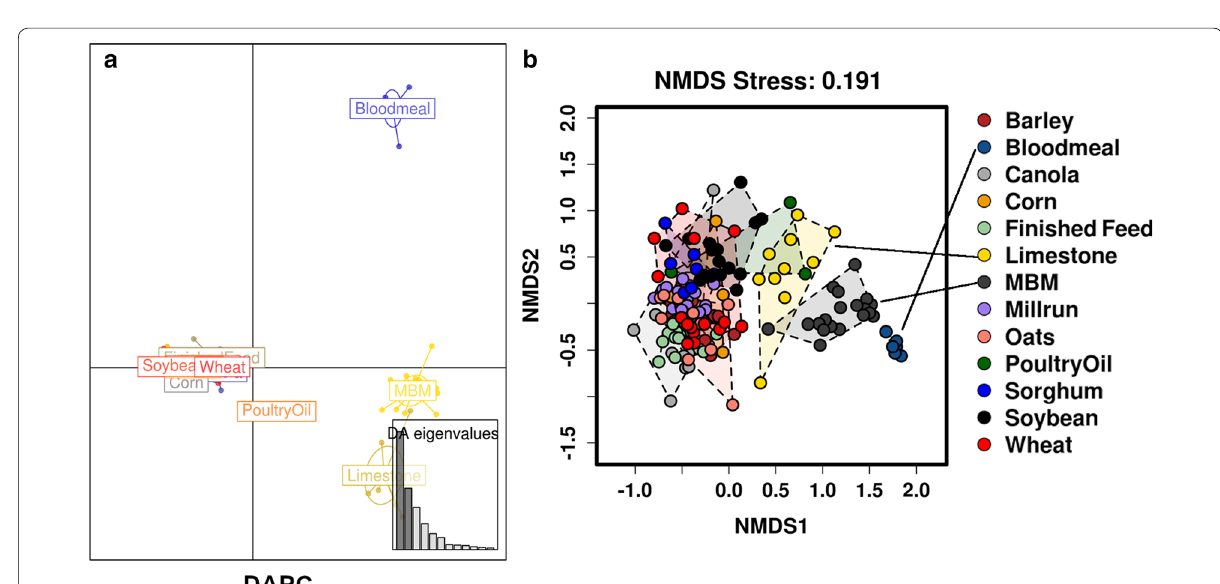
Fig. 3 Multivariate presentation of feed ingredients microbiota similarities, via DAPC ( a ) and NMDS ( b )